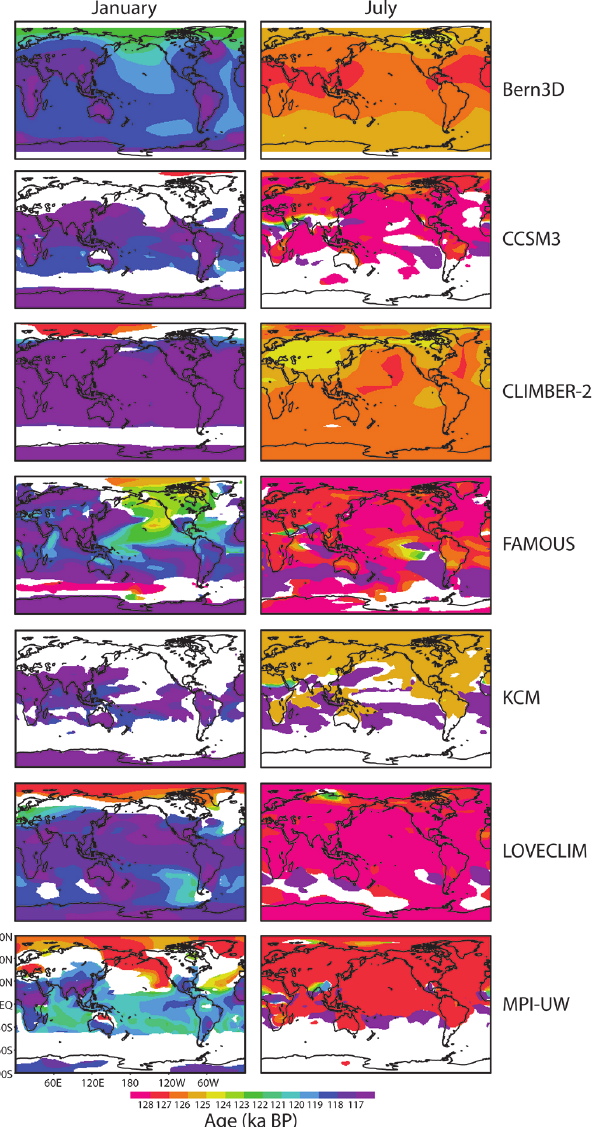
Fig. 4. Timing of the simulated January and July LIG temper- ature maximum (MWT) in the different simulations. The timing (kaBP) is the period for which the highest 50yr average temper- ature anomalies are found along a polynomial fitted to the indi- vidual temperature time series for every grid cell. Values are only shown if the highest temperatures are outside the 2 σ range of the mean LIG temperature anomaly for the specific grid cell. Note that Bern3D has latitudinal grid limits at 76 ◦ N and 76 ◦ S. Furthermore, the MPI-UW and KCM simulations run from 128–115kaBP and 126–115kaBP respectively. Therefore, the colour corresponding to a timing of respectively 128–127kaBP and 126–125kaBP should be interpreted as being > 127kaBP or > 125kaBP in the case of the MPI-UW and KCM simulations. In all simulations shown in this figure, a fixed-day calendar was